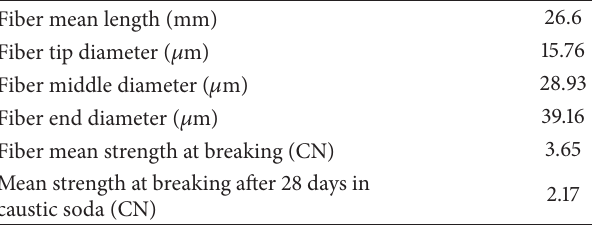
Table 1: Estabragh fibers properties.